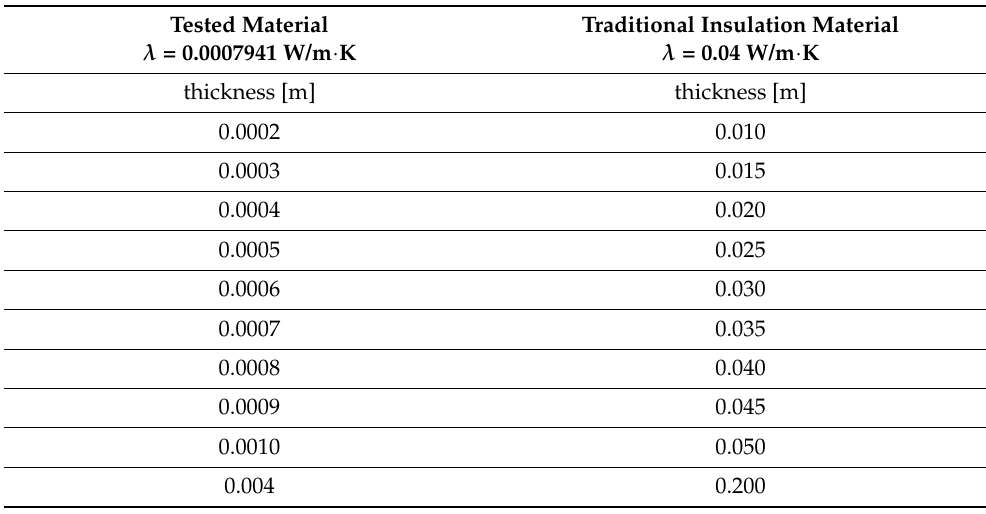
Table 3. Comparison of the tested thin-film material thickness and the corresponding thickness of traditional insulation material (polystyrene or wool with λ = 0.04 W/m · K). Tested Material Traditional Insulation Material λ = 0.0007941 W/m · K λ = 0.04 W/m ·